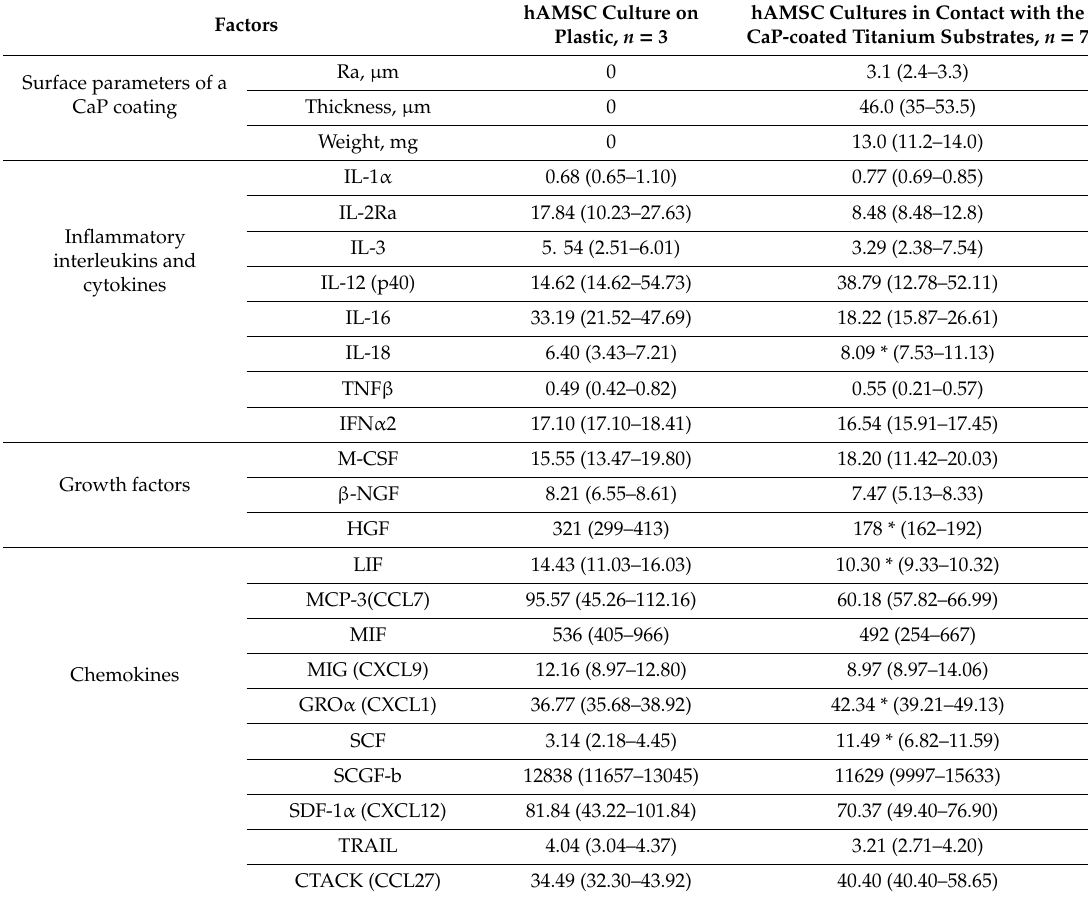
Table 4. Secretory activity (pg / mL) of hAMSCs after 14 days of culture with the microarc CaP-coated titanium substrates, Me